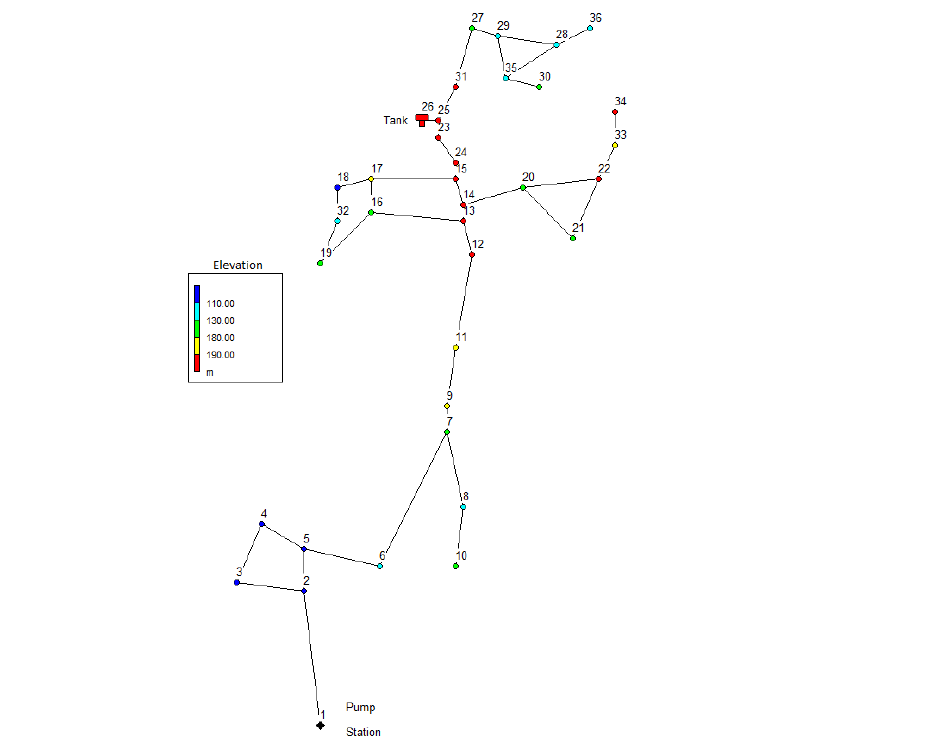
Figure 4. General topology of the WDS under study.